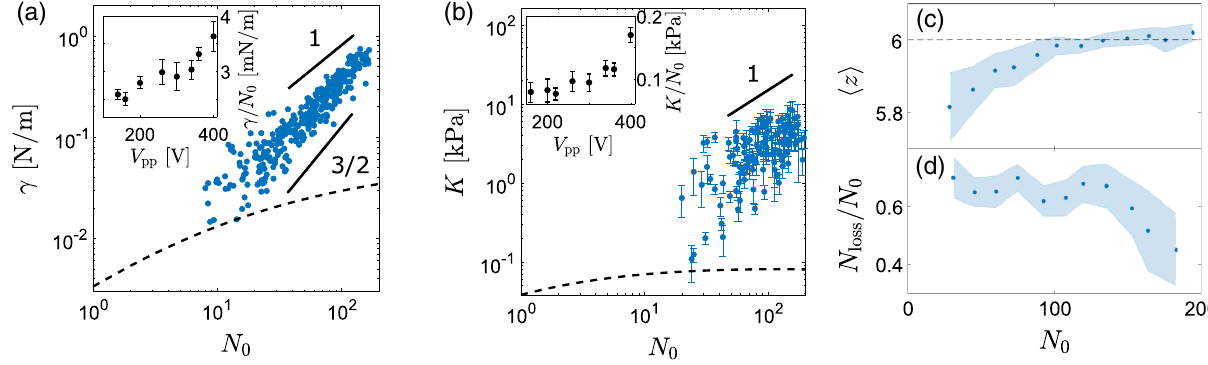
FIG. 4. Contactless measurement of effective surface tension, effective elastic modulus, and microstructural properties. (a) Effective surface tension γ as a function of the initial number of particles in a raft N 0 . The dashed line displays the prediction for γ obtained from integrating the acoustic force [Fig. 2(a)] over the raft body (within a multiplicative prefactor, see Appendix A). Data are shown for ¼ 300 V. Inset: slope of γ with respect to N V transducer peak-to-peak driving voltage V . Error bars indicate 0 , measured for different pp pp standard error. (b) Effective elastic modulus K , defined in analogy to the bulk modulus of a three-dimensional material, as a function of the initial number of particles in a raft N 0 . The dashed line displays the prediction for K obtained from integrating the acoustic force [Fig. 2(a)] over the raft body, with a multiplicative prefactor (see Appendix A). Data are shown on a log-log plot for transducer peak-to-peak driving ¼ 300 V. Error bars indicate the error due to fitting the data. Inset: slope of K with respect to N V voltage V . 0 , measured for different pp pp Error bars indicate standard error. (c) Average coordination number of particles in the raft interior h z i , as a function of N 0 . The dotted line indicates the coordination number for close-packed configurations in two dimensions. (d) Lost number of particles up to maximal plastic deformation, N , normalized by N 0 , as a function of N 0 . Shaded regions indicate the standard loss